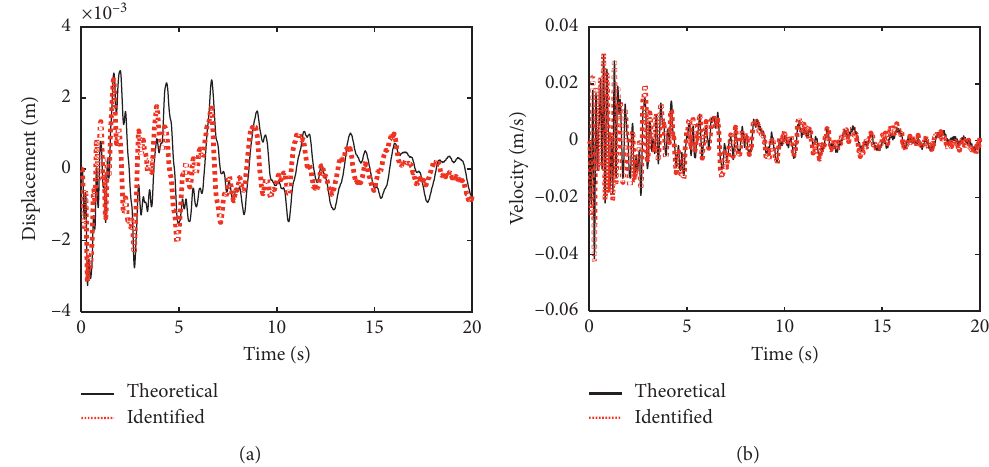
Figure 8: (a) Theoretic and determined vertical shift at node 7 through dummy measurements. (b) Theoretic and determined vertical speed at node 7.